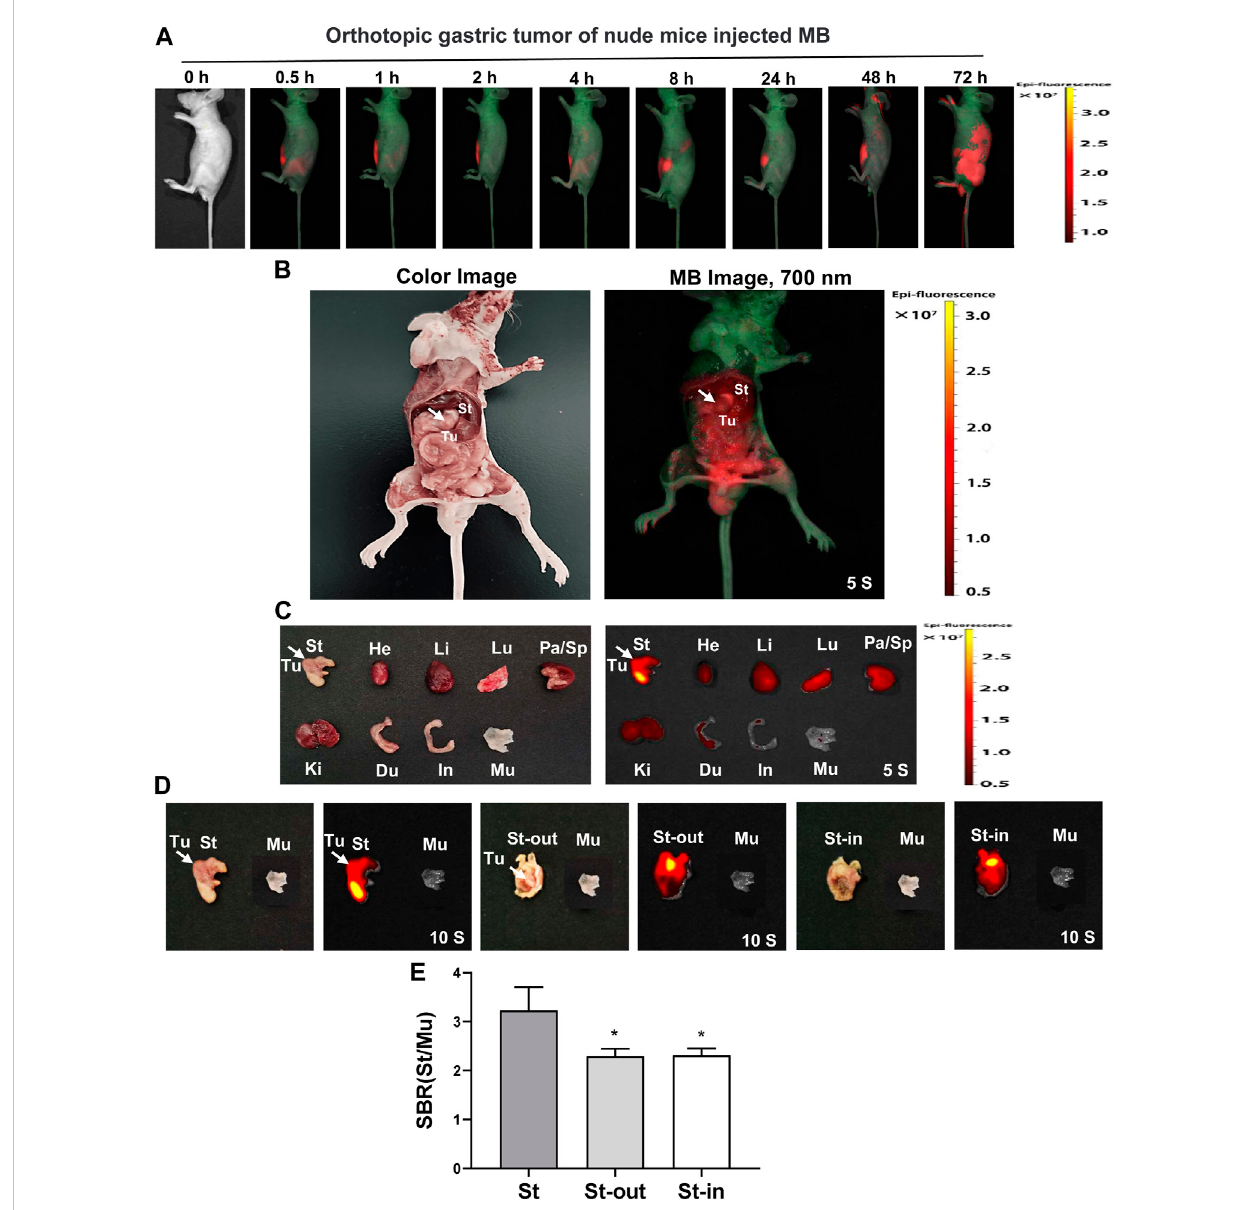
injection under the NIR imaging system. (A) Real-time NIR fl uorescence imaging of gastric orthotopic tumor-bearing nude mice at different time points. (B) NIR imaging of the abdominal cavity of nude mice at 72 h post-injection MB. (C) NIR imaging of resected major organs at 72 h post-injection